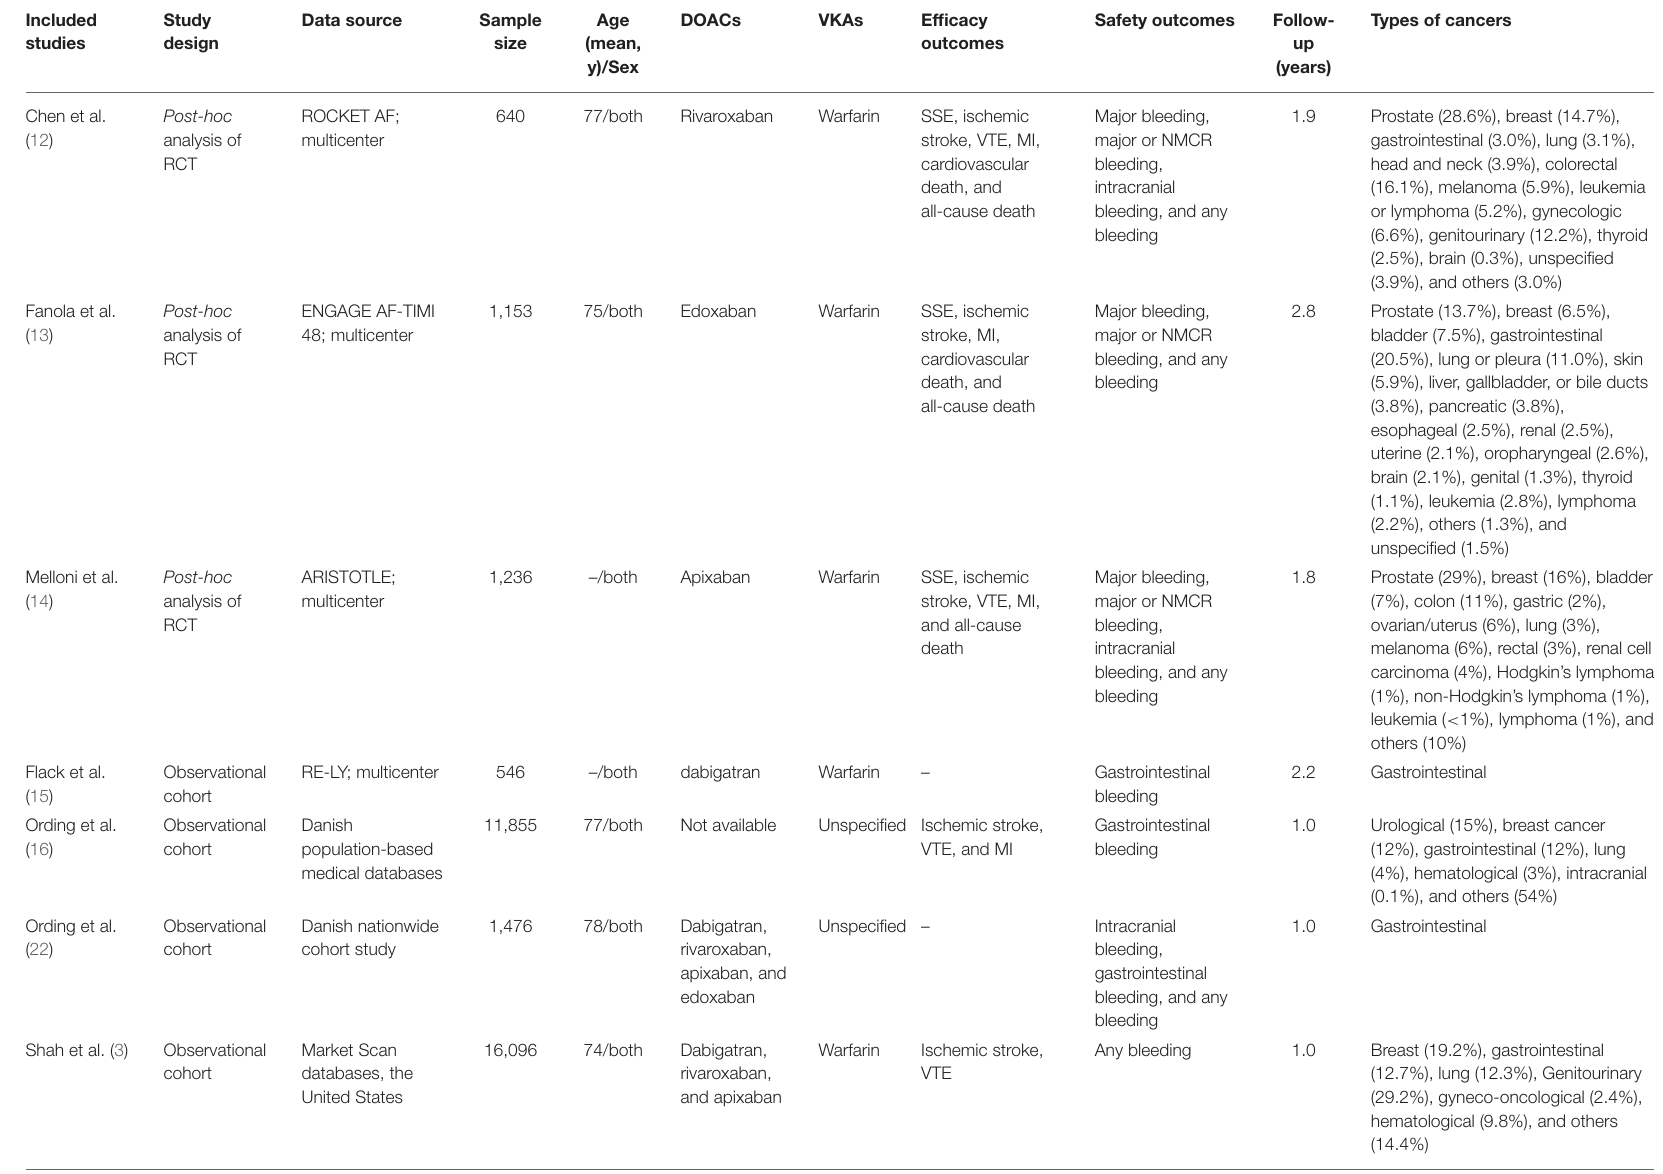
TABLE 1 | Baseline characteristics of the included